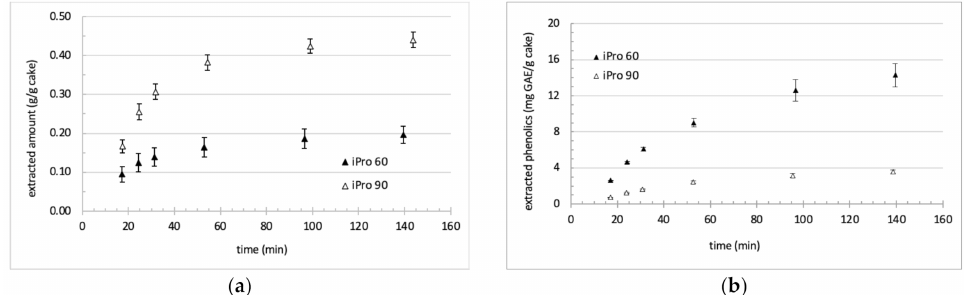
Figure 4. Extraction kinetics of ( a ) global extract and ( b ) total phenolic compounds using isopropanol- based